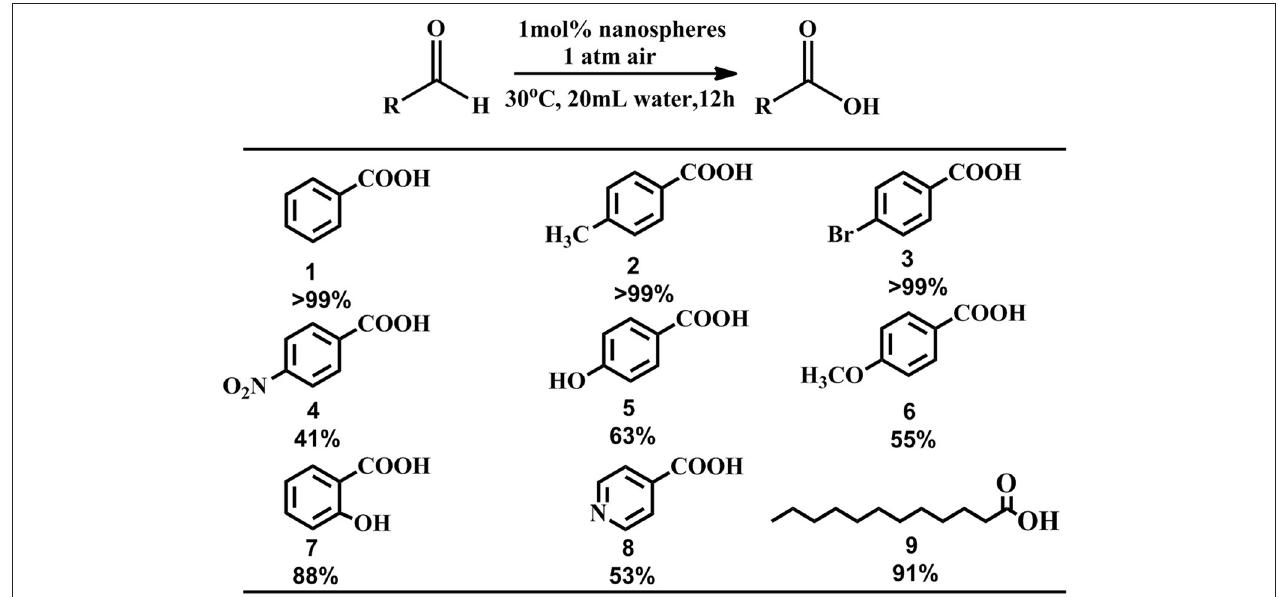
FIGURE 6 | Investigation of substrate